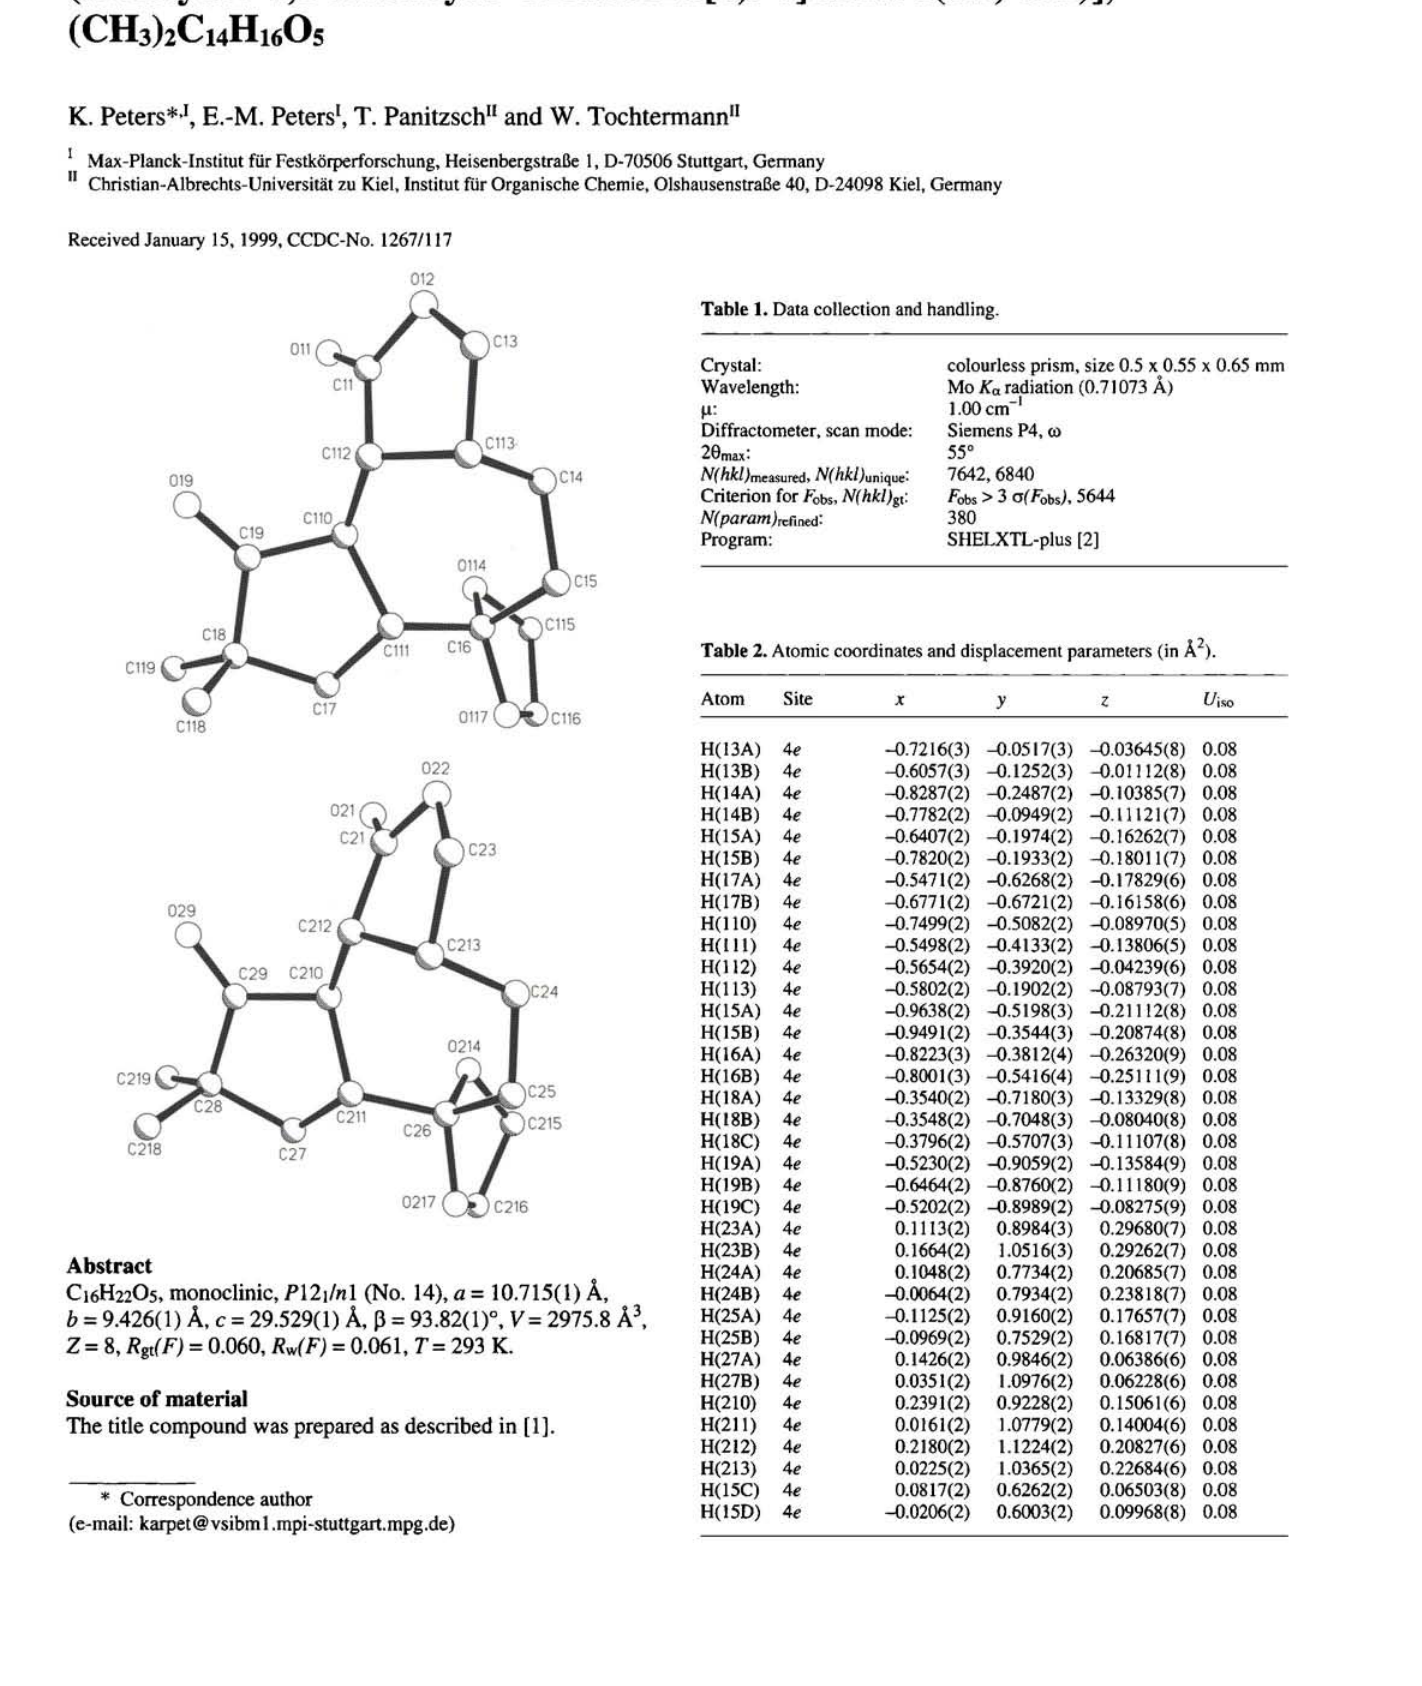
Table 2. Atomic coordinates and displacement parameters (in À 2